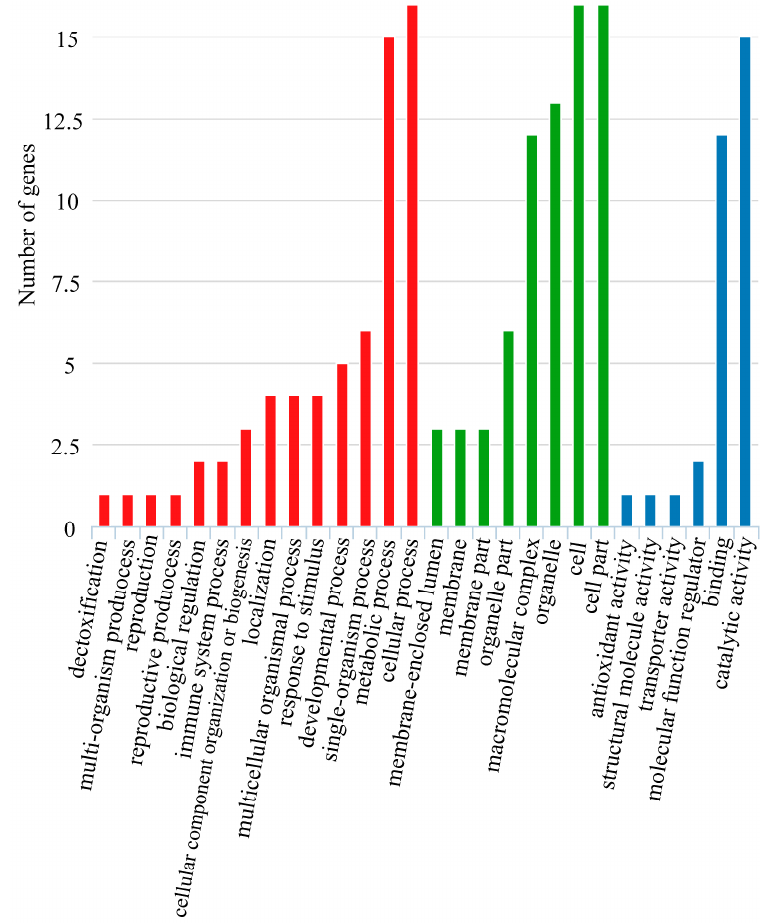
Figure 5. GO enrichment analysis of representative positively selected genes.